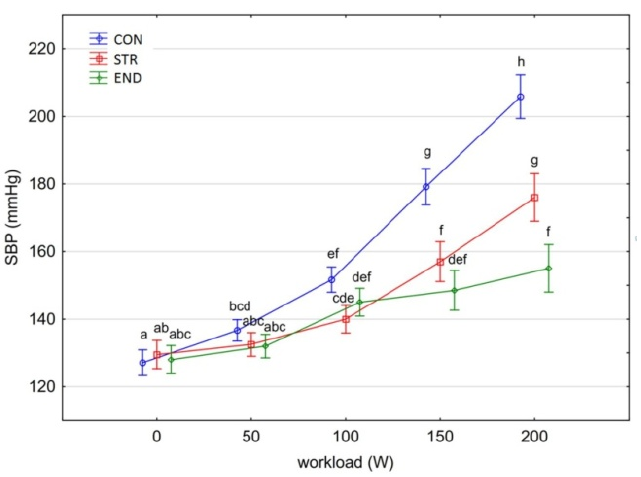
Figure 4. Systolic blood pressure (SBP) at rest and its response during the progressive exercise test; point and whiskers—mean ± 95% CI; the signs—a, b, c, d, e, f, g, h indicate homogeneous groups ( post-hoc Tukey’s HSD test: p > 0.05).